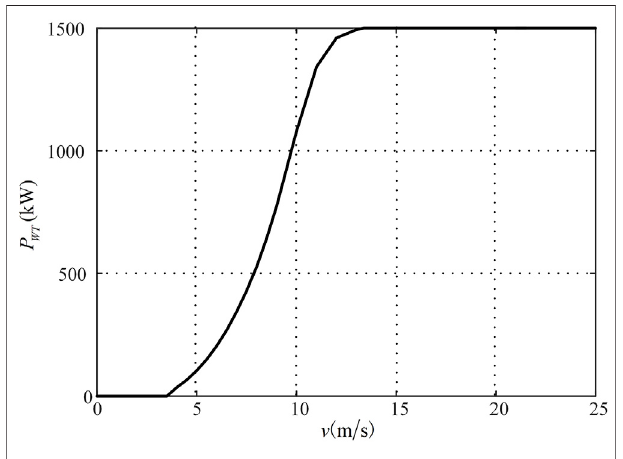
FIGURE 4 | Typical power curve of the wind power generation.